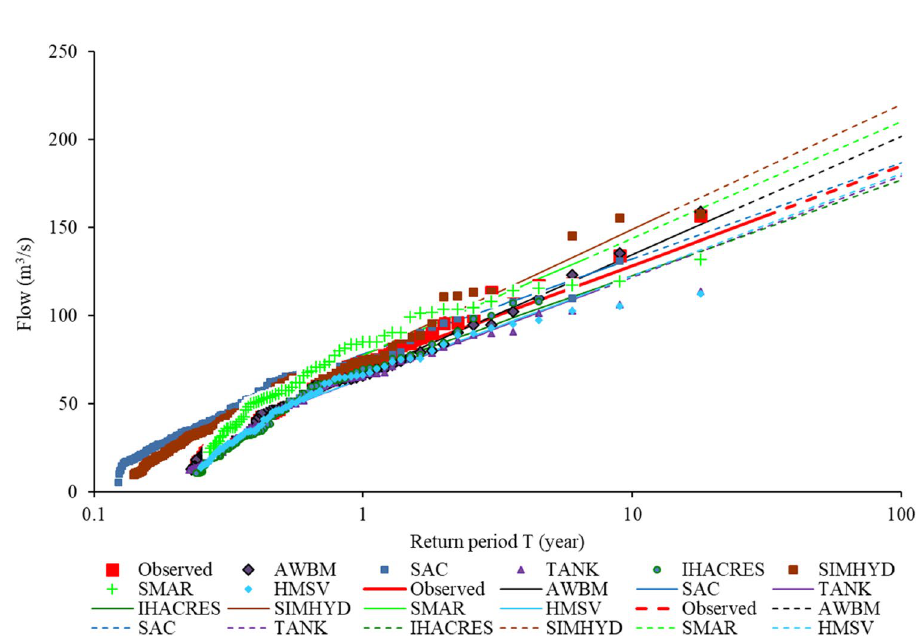
Fig. 9 Assessment of model performance based on com- piled values of ranking from all the nine “goodness-of-fit” considering the annual minima flows. The best performing model is ranked 1 while the worst takes rank 7